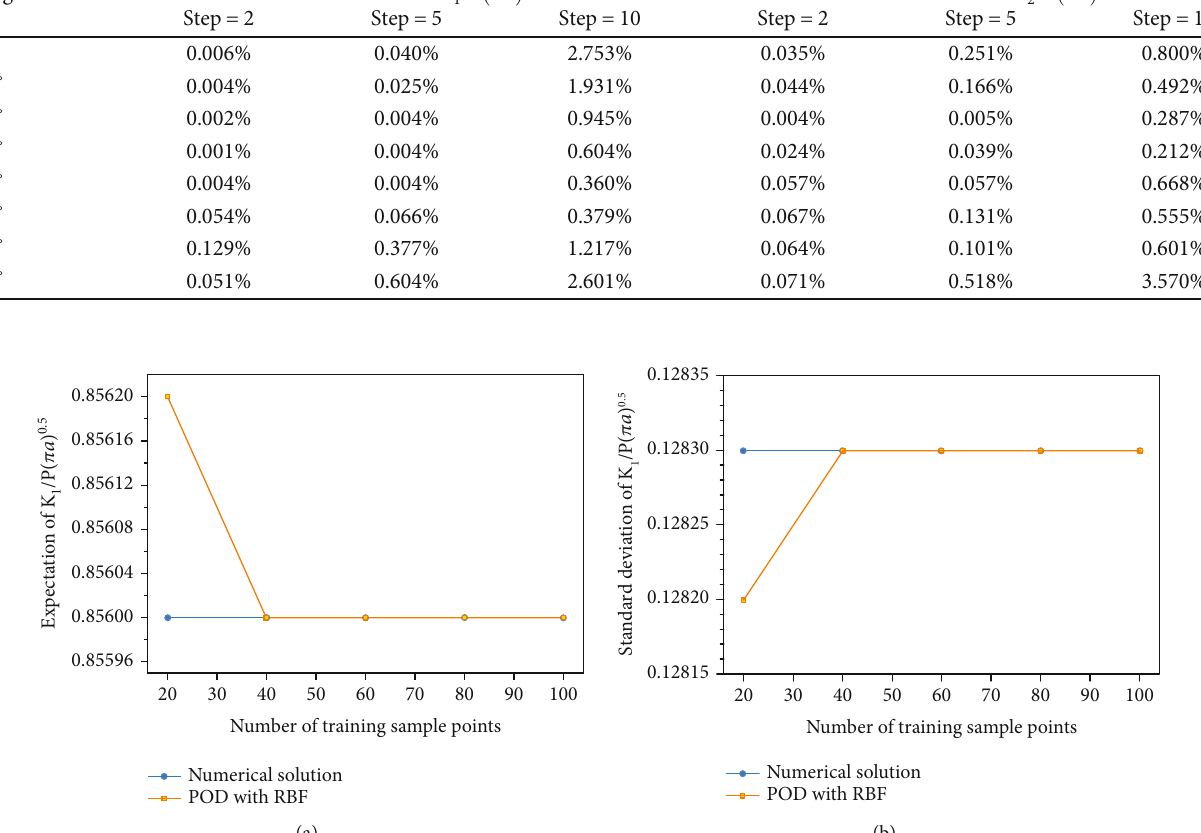
Figure 10: Expectations and standard deviation of di ff erent degrees of reduction: (a) expectations of the normalized SIFs K di ff erent sample points; (b) standard deviation of the normalized SIFs K